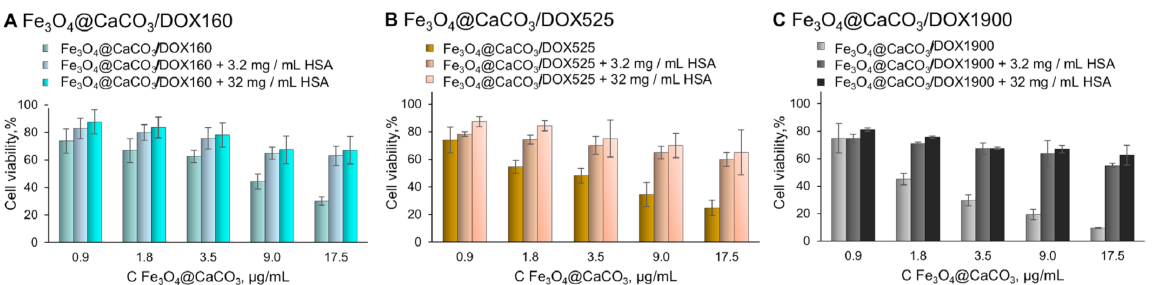
Figure 11. Cell viability assay using MTT. MCF-7 cells were incubated with Fe 3 O 4 @CaCO 3 /DOX and Fe 3 O 4 @CaCO 3 /DOX-HSA for 48